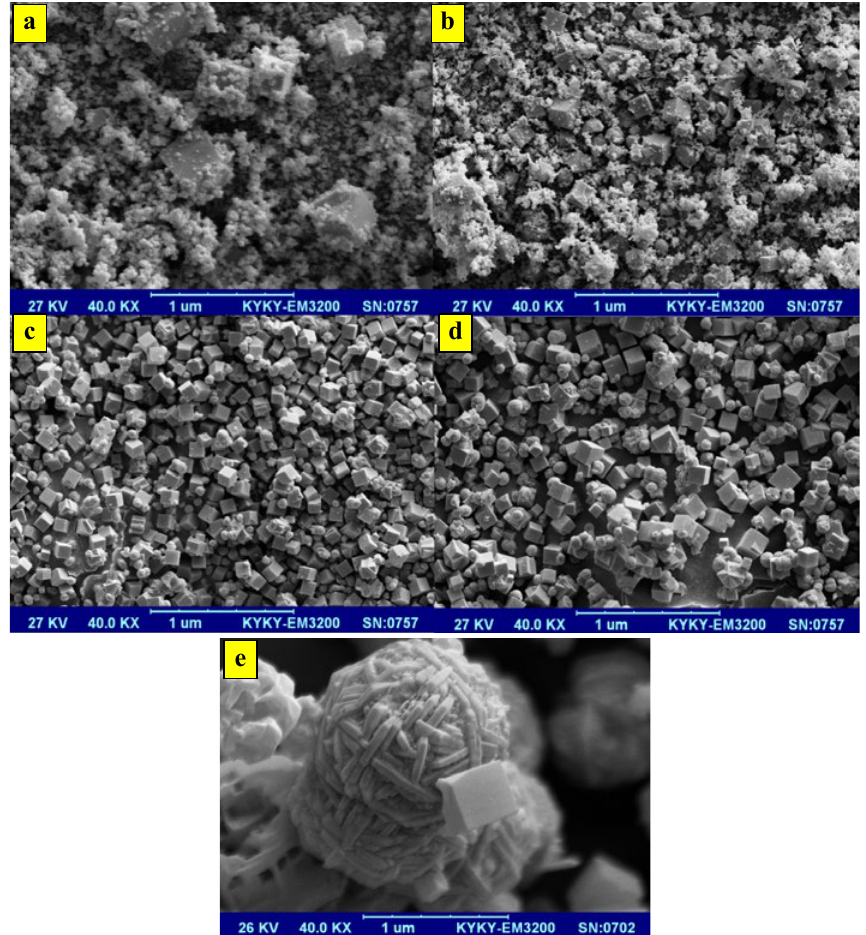
Fig. 3: SEM images of samples synthesized at 98 o C at different hydrothermal time. (a) 30 h, (b) 48 h, (c) 72 h, (d) 96 h. (e) yarn ball like morphology.